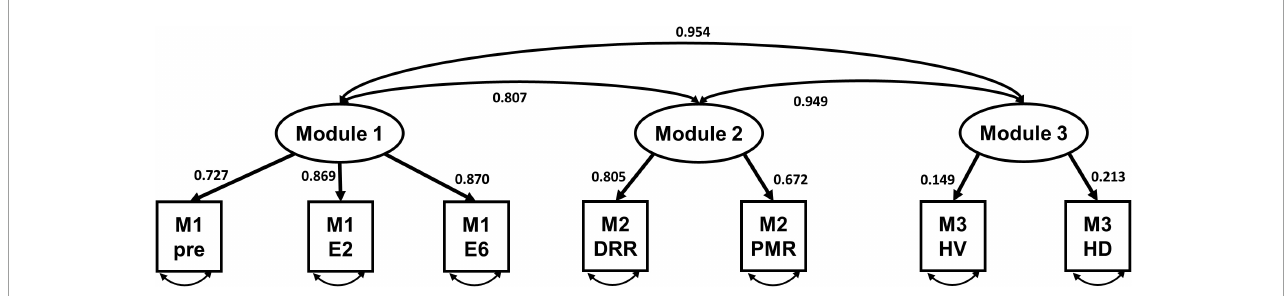
FIGURE4 The standardized model of the three-factor heart rate variability (HRV) index of virtual reality-based assessment in panic disorder (VRA-PD). M, module; DRR, diaphragmatic respiratory relaxation; PMR, progressive muscle relaxation; HV, hyperventilation; HD, head down.